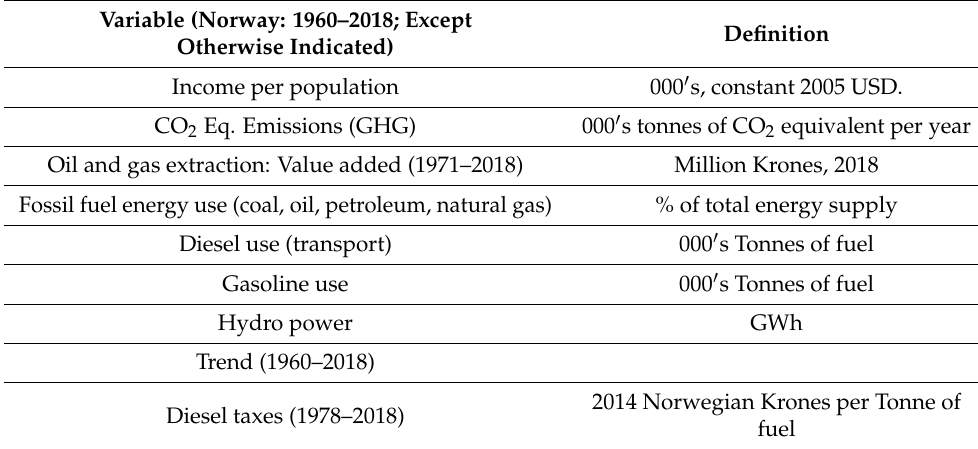
Table 4. Definition of variables for Norway in